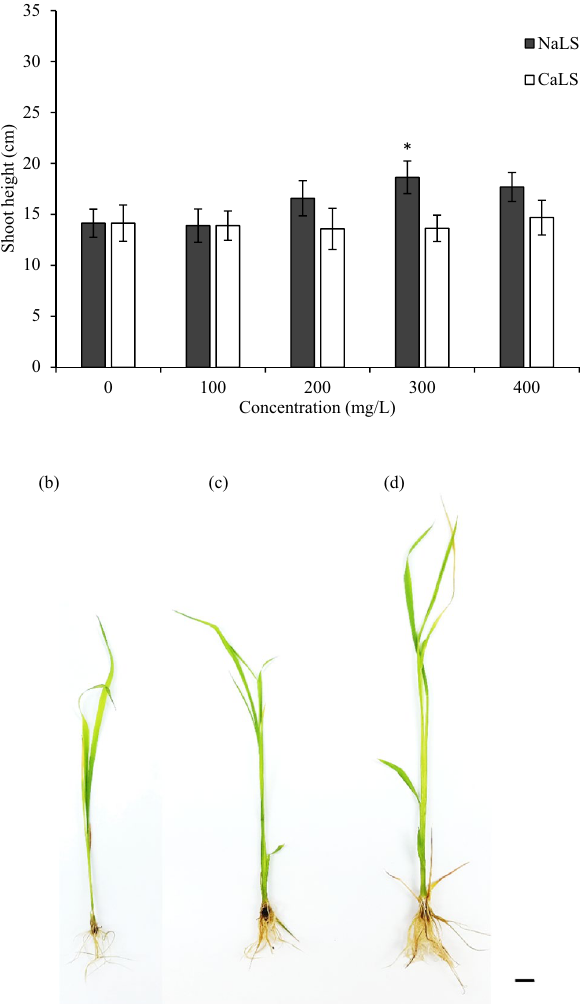
Figure 1. The MR 219 rice shoot growth in response to NaLS and CaLS treatments. ( a ) Shoot height after 3 weeks culture period in MSO, NaLS- and CaLS-supplemented medium. Phenotype of MR 219 rice showing the shoot growth after 3 weeks incubation on ( b ) MSO and ( c ) 300 mg/L CaLS- and ( d ) 300 mg/L NaLS- supplemented medium. Data shows mean of three biological replicates, n = 10, with error bars represent standard deviation. Asterisk represent the significantly difference between treatments at p < 0.05 when compared to MSO. Scale bars represent 1